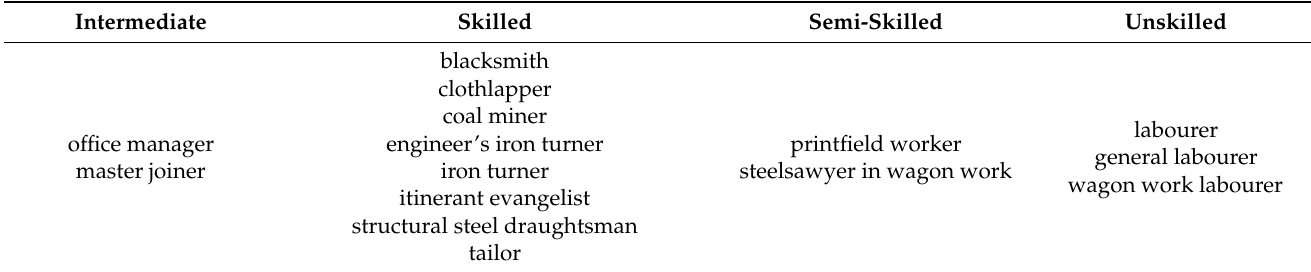
Table 2. Social class of fifteen members of the Needed Truth Churches of God,